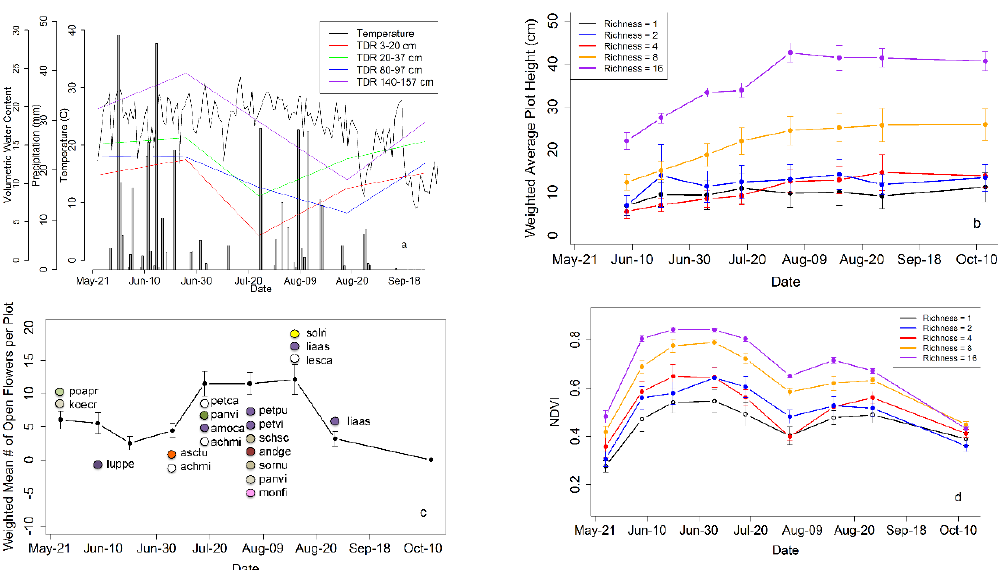
Figure 5. Time series of air temperature (maximum temperature of the day), precipitation, soil moisture expressed as volumetric water content ( a ); weighted average plot height ( b ); weighted mean number of open flowers per plot ( c ) and NDVI plotted by species richness ( d ) over the growing season in 2014. In Figure 5c, the approximate flower color is indicated by the colored circles, and the species names are indicated by 5-letter abbreviations (see Table S2 in Supplementary Materials for full species names).